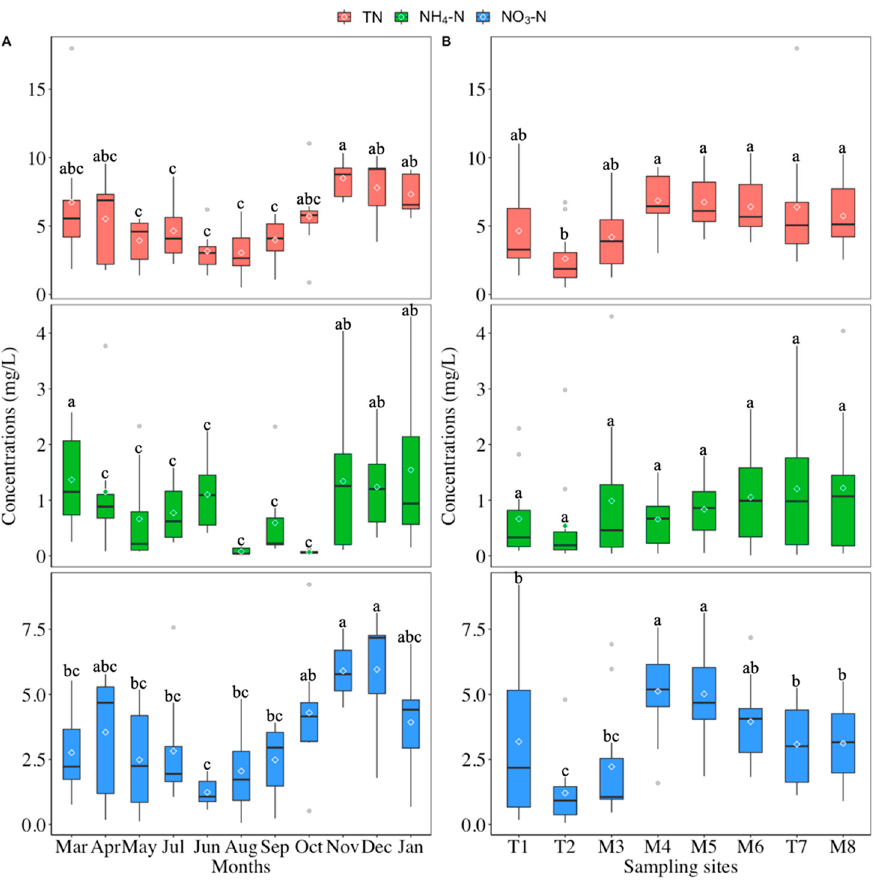
Figure 2. The temporal ( A ) and spatial ( B ) variations in concentrations of TN, NH 4+ -N and NO 3 − -N in eight sites in the Yuntaishan River basin. Letters on boxes represent statistical significance, and different letters and same letters indicate difference between these two boxes is significant ( p < 0.05) and insignificant ( p > 0.05) based on an ANOVA, respectively. Each month in ( A ) is an average of all stations, and each sampling site in ( B ) means the yearly average.